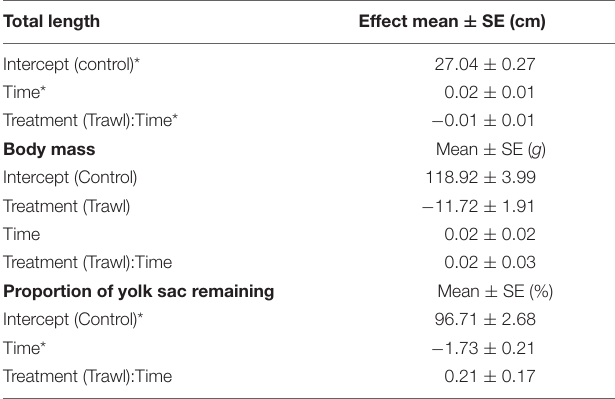
TABLE 2 | Effects obtained from the most parsimonious linear mixed effects model illustrating the influence of time and maternal treatment group [Control ( n = 16) or Trawl ( n = 11)] on neonate total length, body mass, and proportion of yolk sac volume